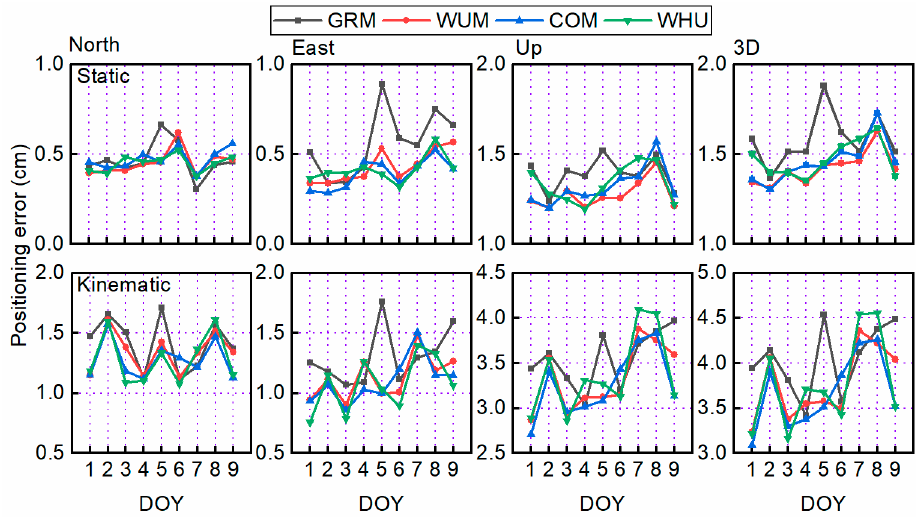
Figure 5. Average positioning errors series among nine days of static (top) and kinematic (bottom) GPS-only PPP AR in north, east, up, and 3D components with GRM, WUM, COM, and WHU products.